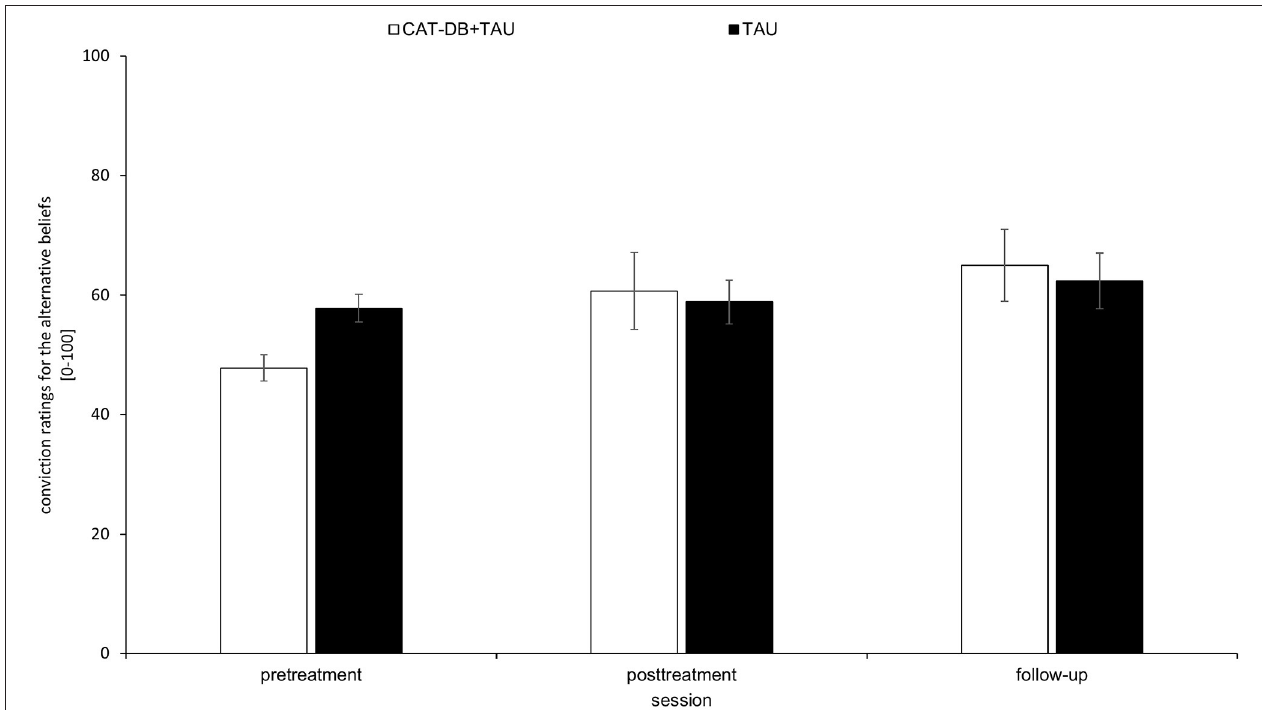
FIGURE 4 | Mean score of the conviction ratings for the alternative beliefs in the CAT- DB + TAU group ( n = 17) and the TAU group ( n = 16) at pre-treatment, at post-treatment and at follow-up. Error bars represent standard errors.